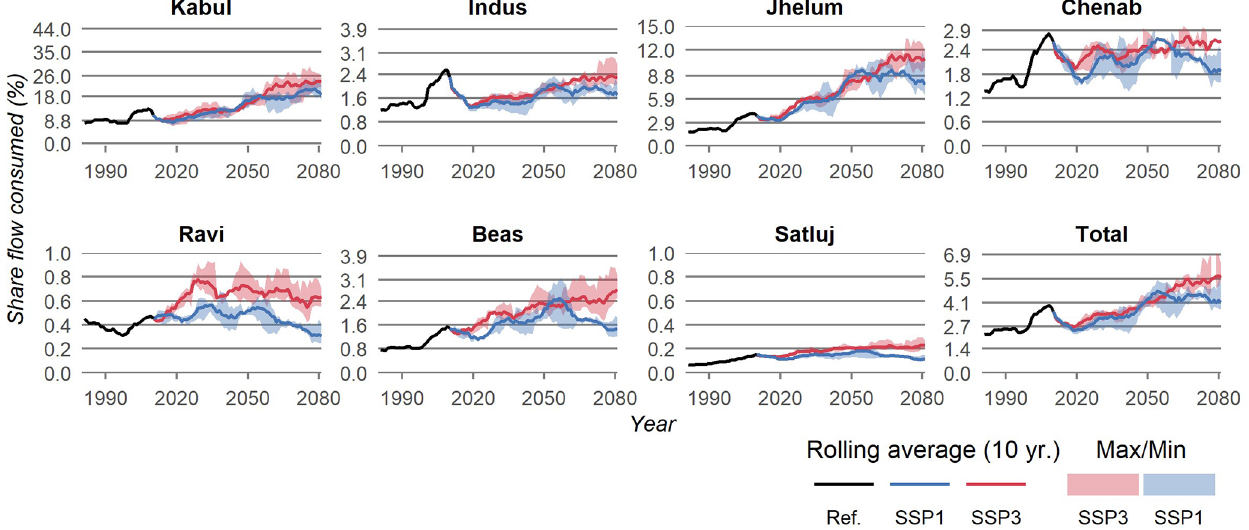
Figure A1. Share of annual discharge consumed in each sub-basin and for the total upper Indus